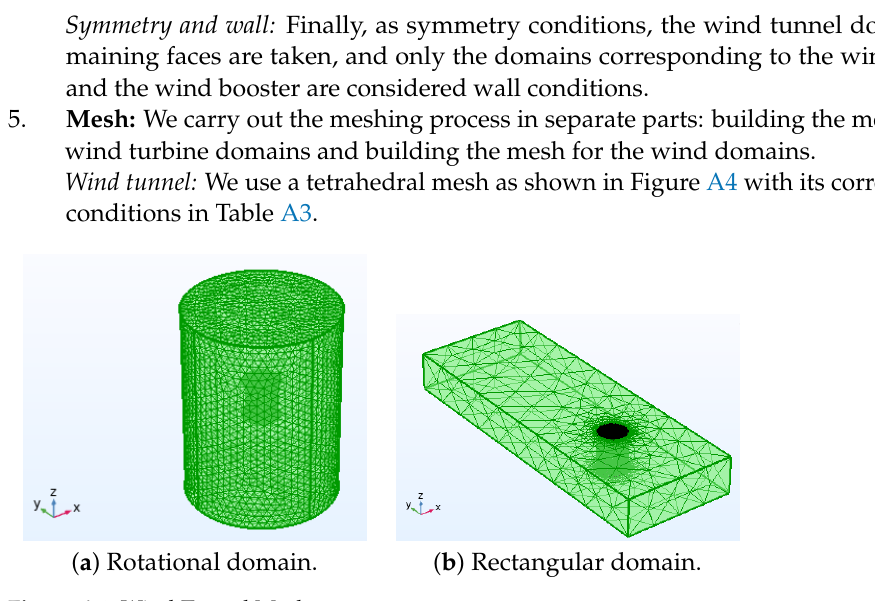
Figure A3. Boundary conditions.